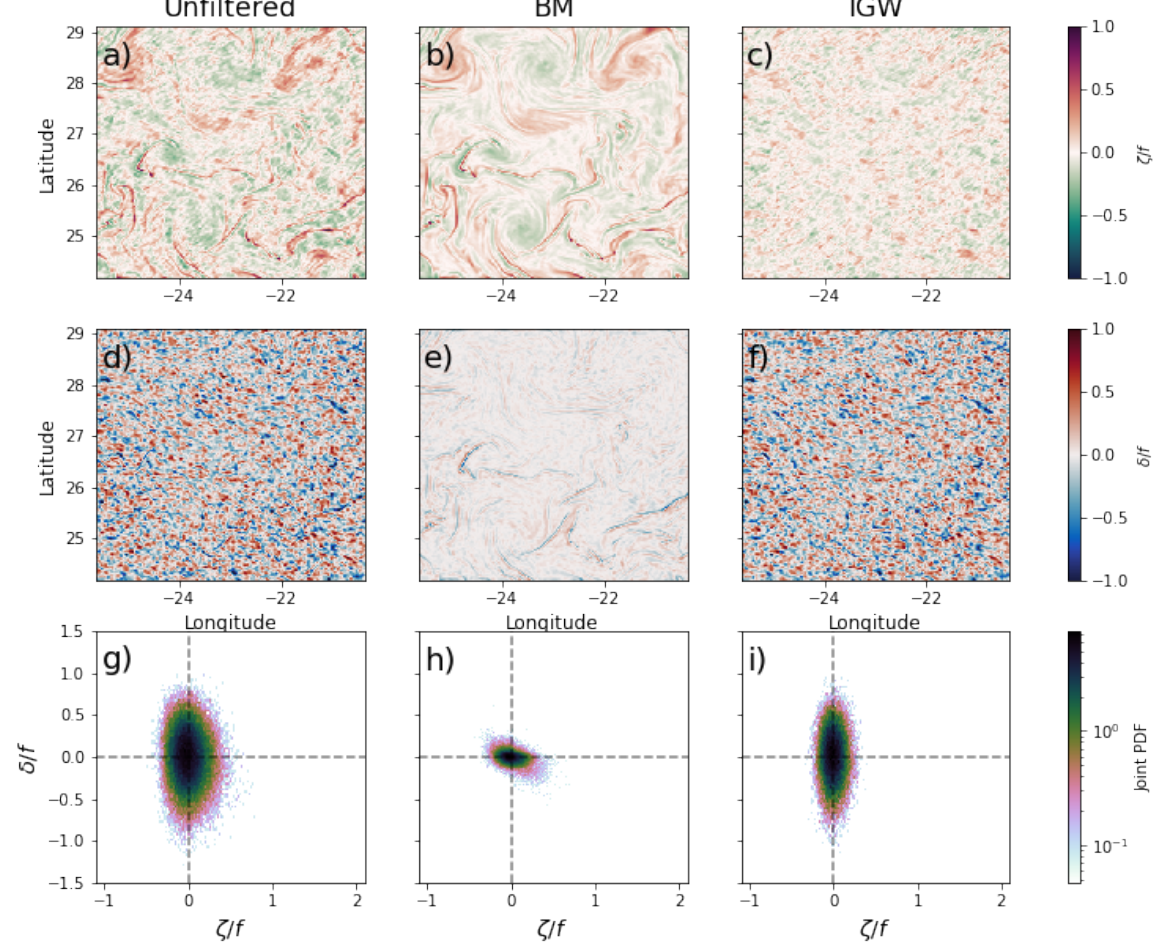
Figure 7. Snapshots of the normalized relative vorticity ( ζ / f : ( a – c )), divergence ( δ / f : ( d – f )), and joint ζ - δ PDF ( g – i ) for a snapshot on 30 September 2012 at Canary (26.64 ◦ N). Fields are shown in an unfiltered state ( a , d , g ) as well as for the BM ( b , d , h ) and IGW ( c , e , i ) regimes. JPDF bin colors are presented on a logarithmic